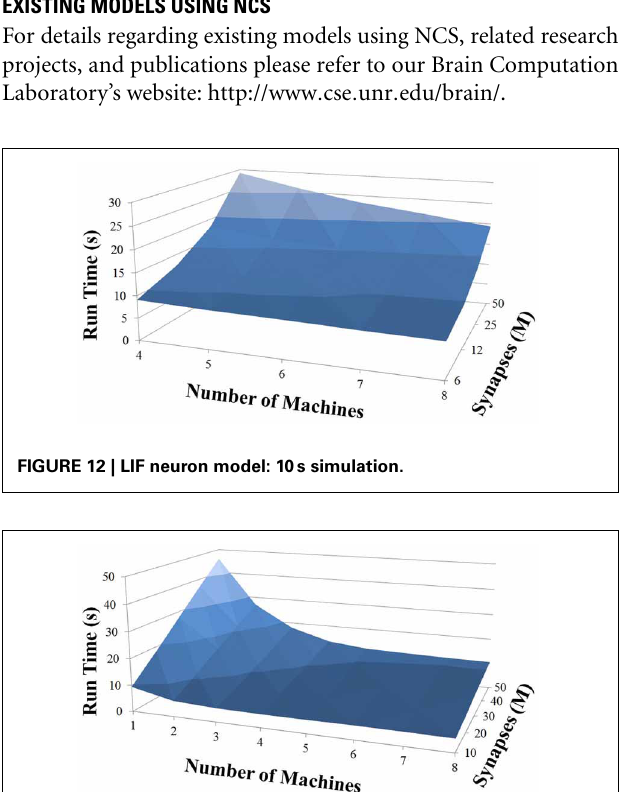
FIGURE 13 | IZH neuron model: 10s simulation.